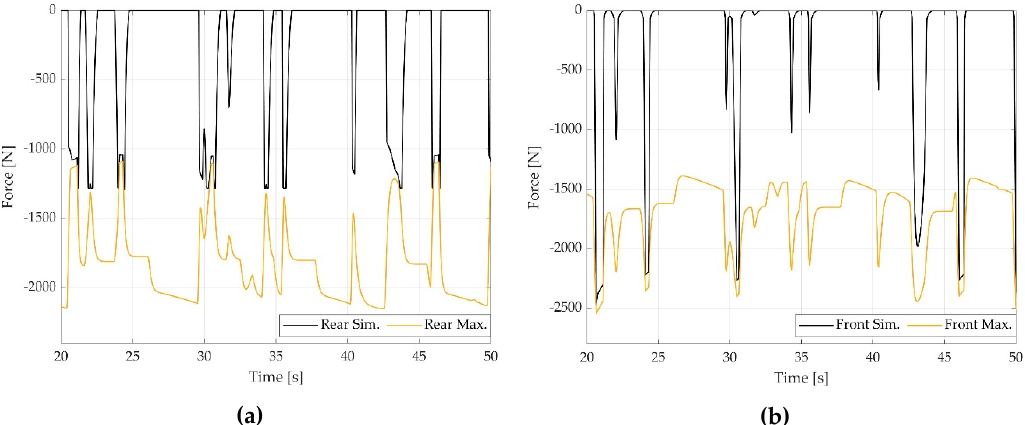
Figure 12. Braking forces and maximal forces ( a ) rear wheels; ( b ) front wheels.